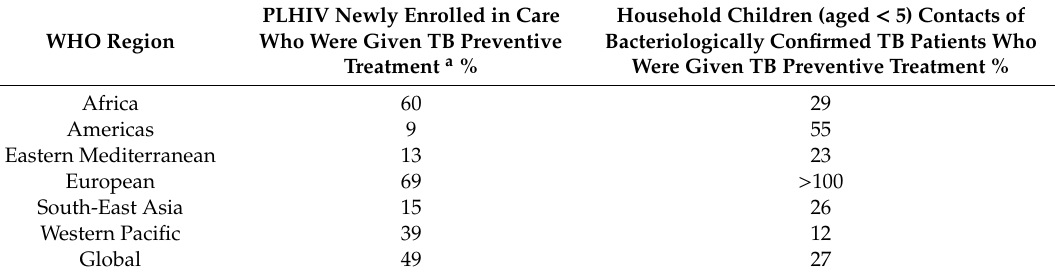
Table 1. Tuberculosis (TB) preventive treatment in